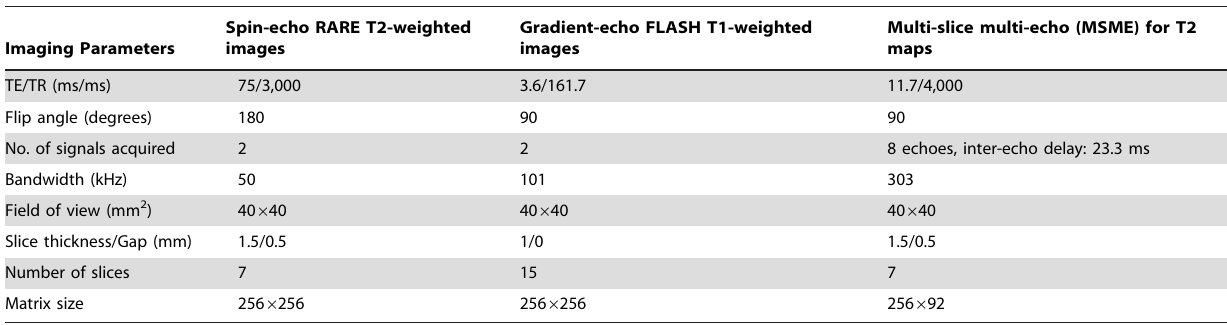
Table 3. MR imaging